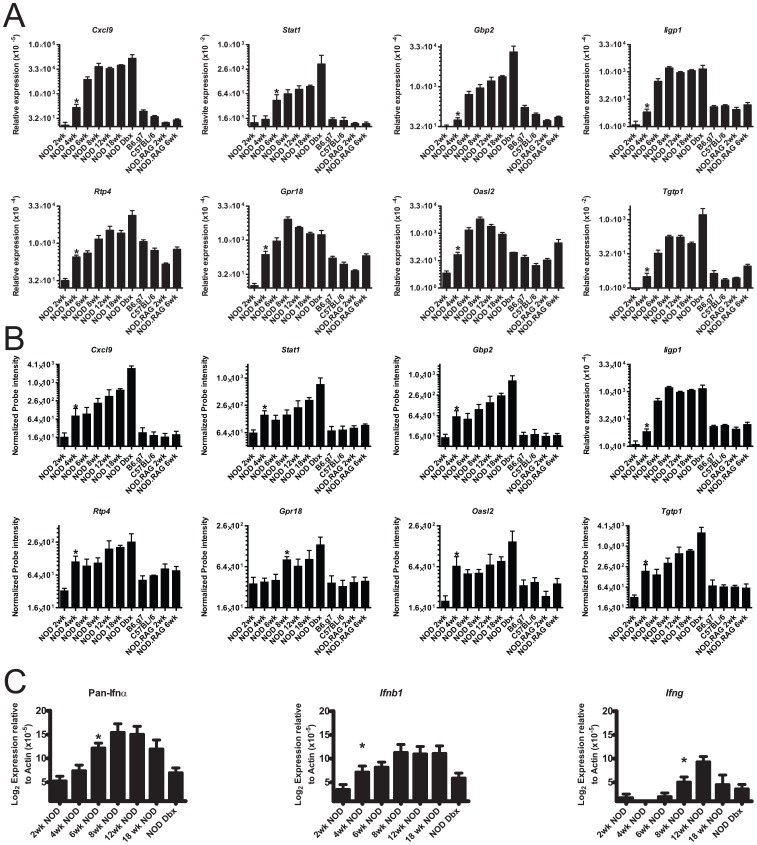
Quantitative RT-PCR validation of microarray data.(A) Quantitative RT-PCR was performed using SYBR green detection for the indicated genes. Bars show the mean (log2) +/− S.E.M. of at least three independent experimental replicates from 3–6 biological replicates per group. All data is represented relative to the expression of actin (ΔCt). In order to facilitate visualization on a log2 scale, values were transformed as indicated on the y-axis label. (B) Microarray results for the same genes interrogated in (A). (C) Taqman qPCR quantification of pan-IFNα, Ifnb1, or Ifng throughout diabetogenesis. Bars represent the mean of the normalized probe intensity +/− S.E.M. of 3–6 biological replicates per group. Asterisks indicate statistical significance (P<0.05) from 2 wk NOD sample by one-tailed Mann-Whitney test.